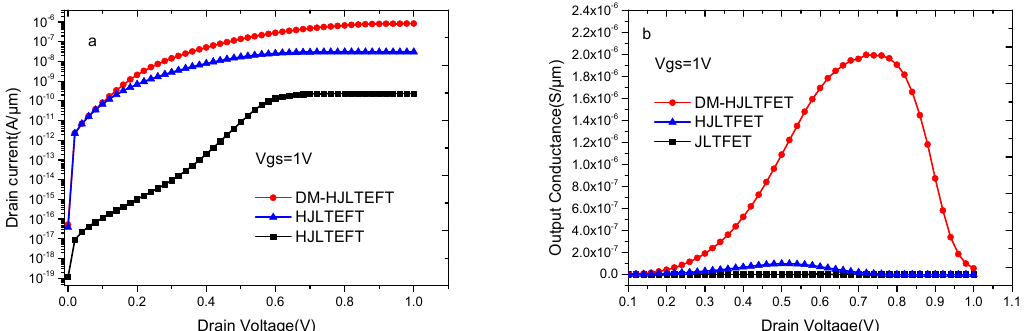
Figure 5. ( a ) Simulated output characteristics and ( b ) Simulated output transconductance of JLTFET, HJLTFET and DMMG-HJLTFET at Vgs = 1 V.